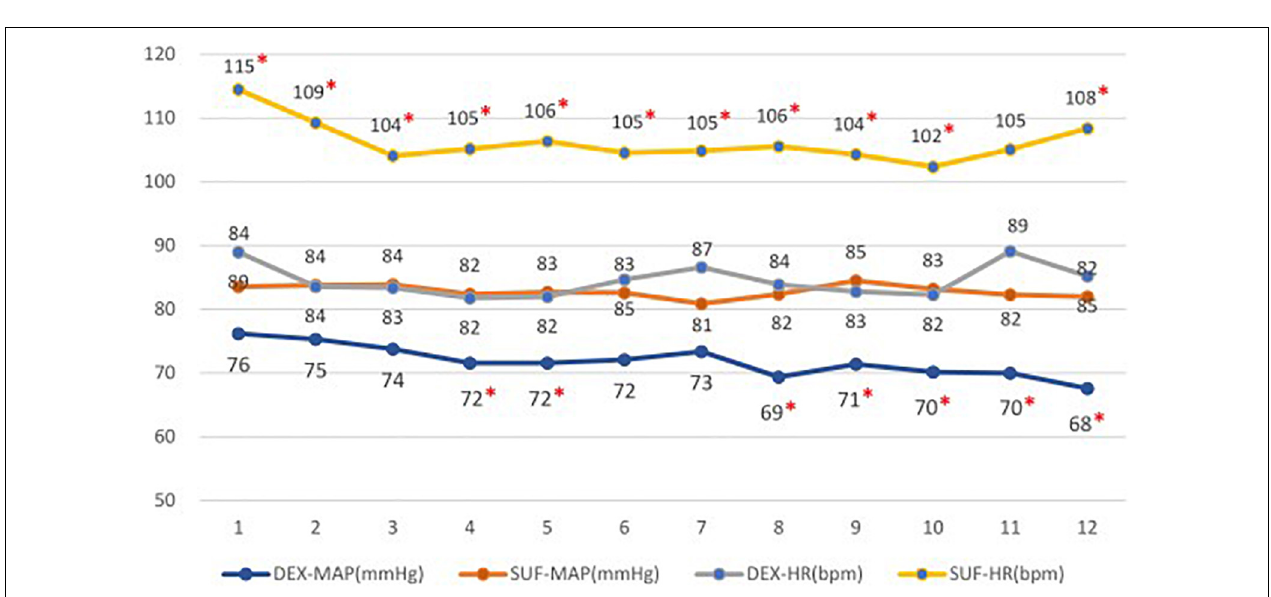
FIGURE 3 | Sleep stages of patients aged > 6 years old in the SUF and DEX experimental groups. ∗ P < 0.05, from the comparison between the SUF and DEX groups.